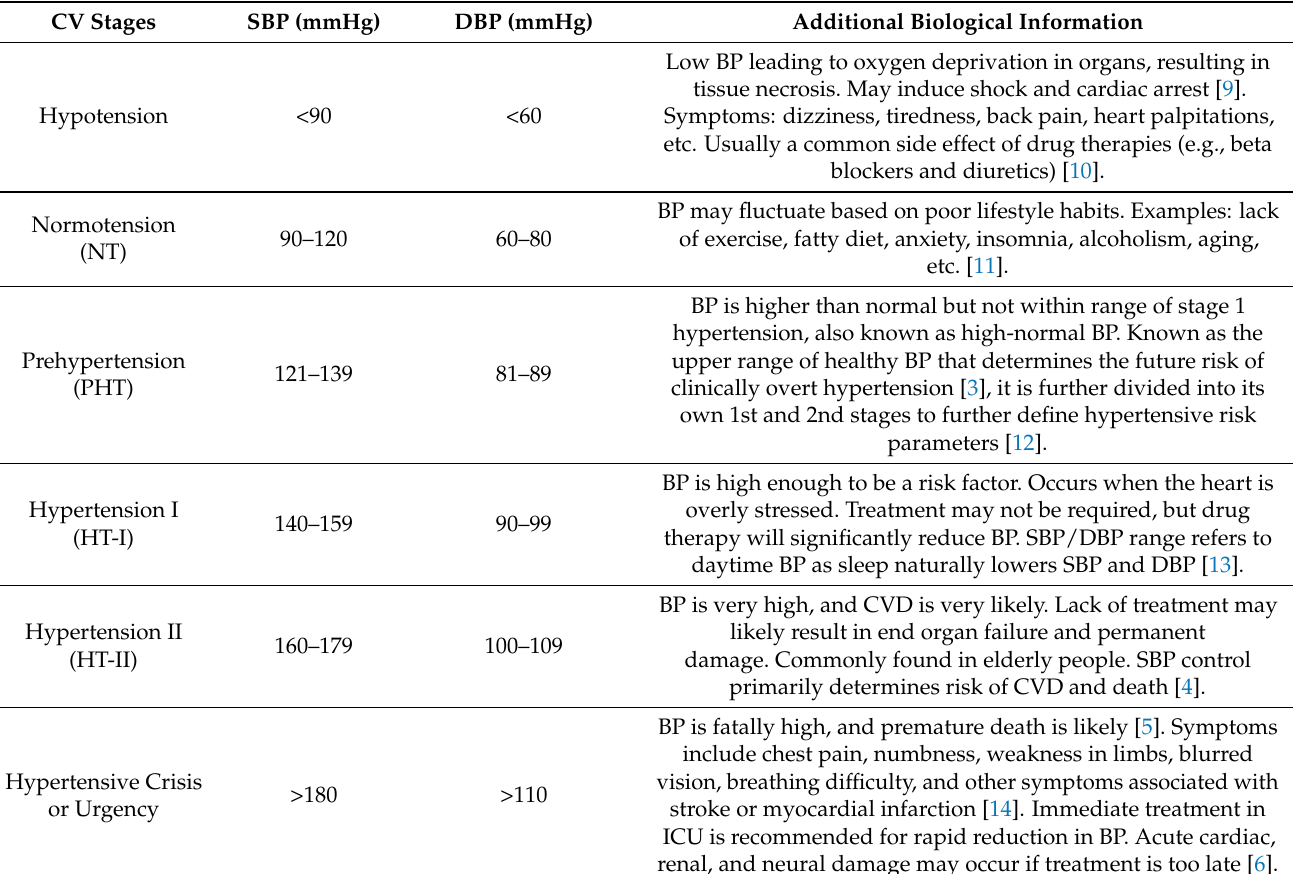
Table 1. Different stages of cardiovascular (CV) health. For details on treatment, see